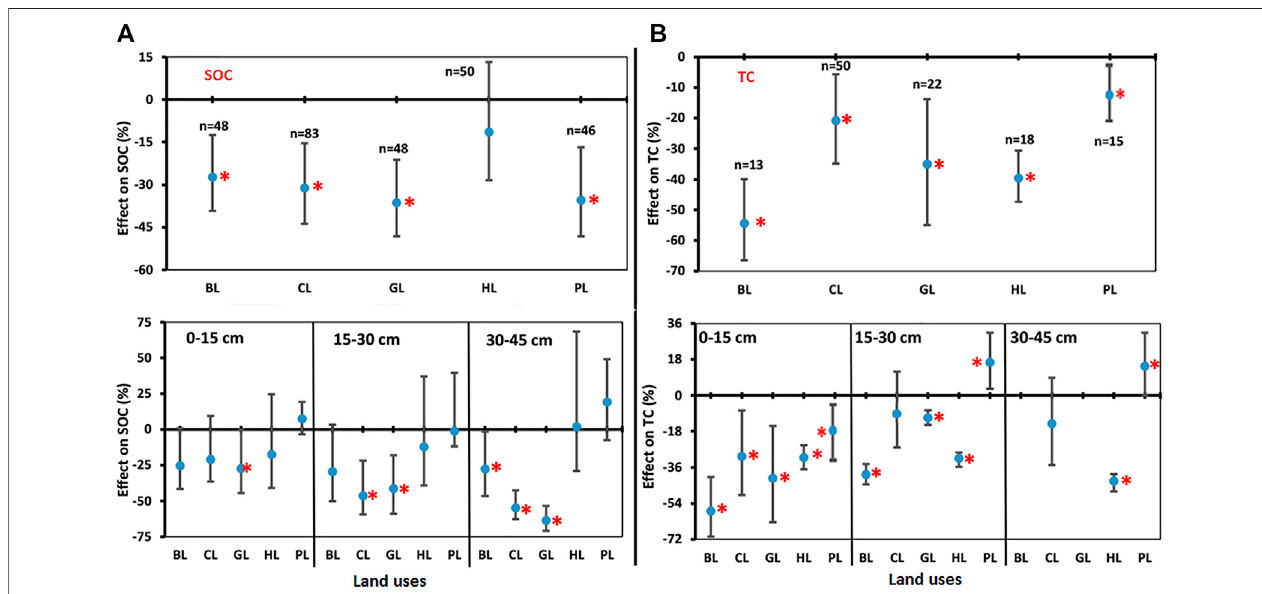
FIGURE 4 | Comparisons of soil properties. (A) Soil organic carbon (SOC), and (B) total carbon (TC) under various land uses (BL, CL, GL, HL, and PL) with FL based on soil depths (0 – 15 cm, 15 – 30 cm, and 30 – 45 cm). The error bars show 95% con fi dence intervals (CI) and the difference is signi fi cant if it does not pass zero. *indicates signi fi cant difference at p -value is less than 0.05. Here, Forest land (FL) is used as control, BL — Barren land, CL — Cultivated land, GL — Grassland, HL — Horticulture land, and PL — Plantation land.